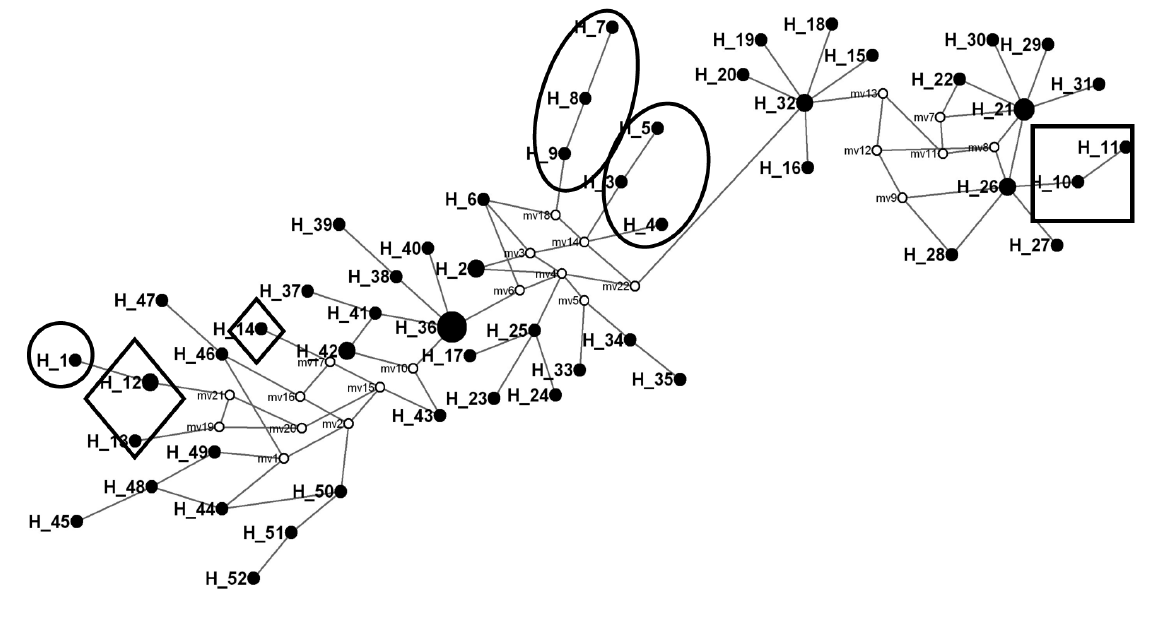
Figure 4. Network of inferred Hop stunt viroid (HSVd) haplotypes. Nodes are proportional to haplotype frequencies; Branch’s length is proportional to the number of mutations. Tunisian pomegranate HSVd variant: ◊Tunisian clementine • HSVd variants. □ Tunisian fig HSVd